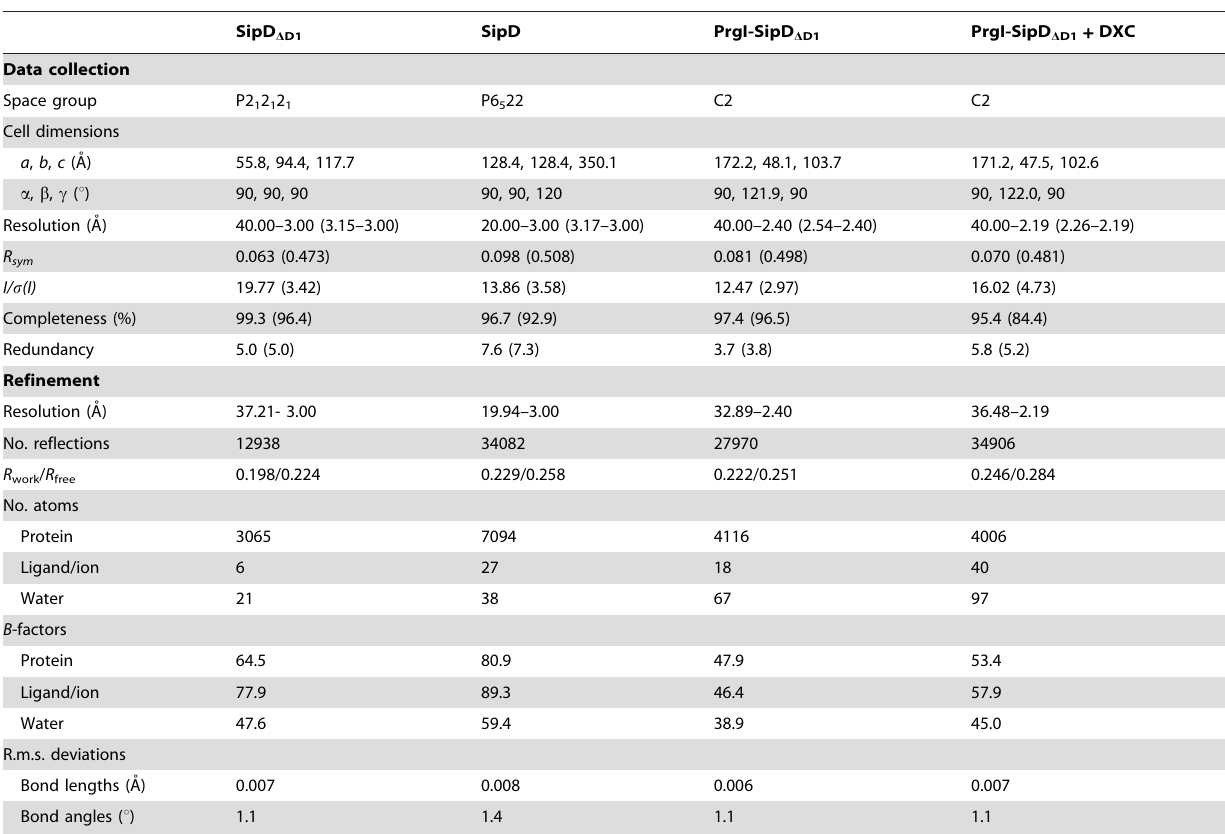
Table 1. Data collection and refinement